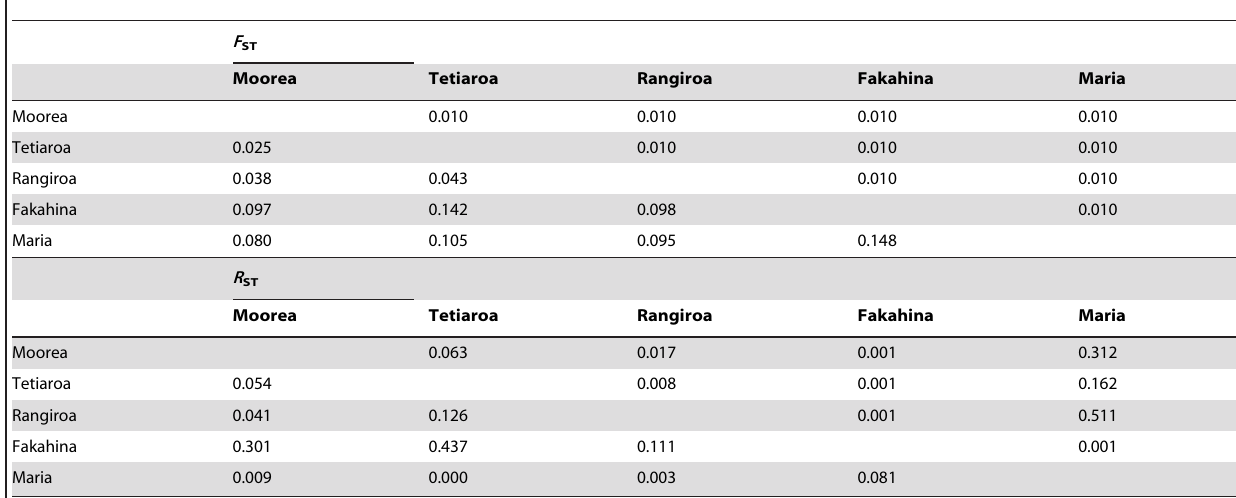
Table 2. Pairwise F ST and R ST values from GenAlEx. P-values are above diagonal.